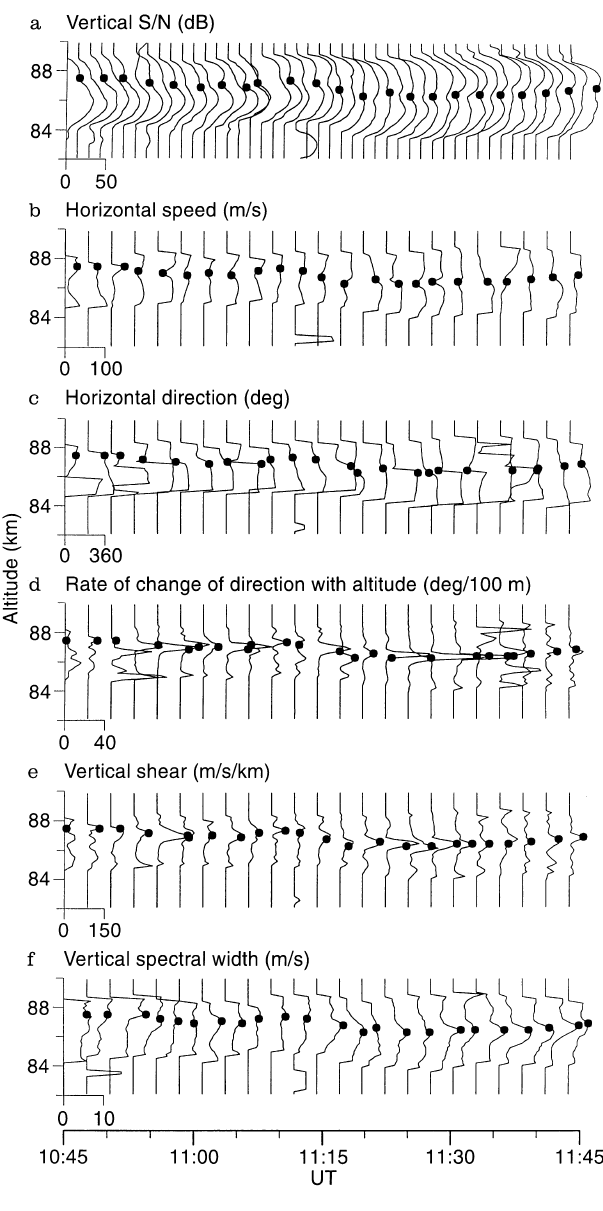
Fig. 5a–f. Altitude profiles of a the vertical S/N, b horizontal speed, c horizontal direction, d rate of change of direction with altitude, e vertical shear and f vertical spectral width on 2 July 1993. A direction of 0 (cid:14) = 360 (cid:14) represents wind travelling to the north. The bold dots , shown for every other profile in a, and for every profile in b–f , mark the altitude of the bifurcation determined subjectively from the profiles in